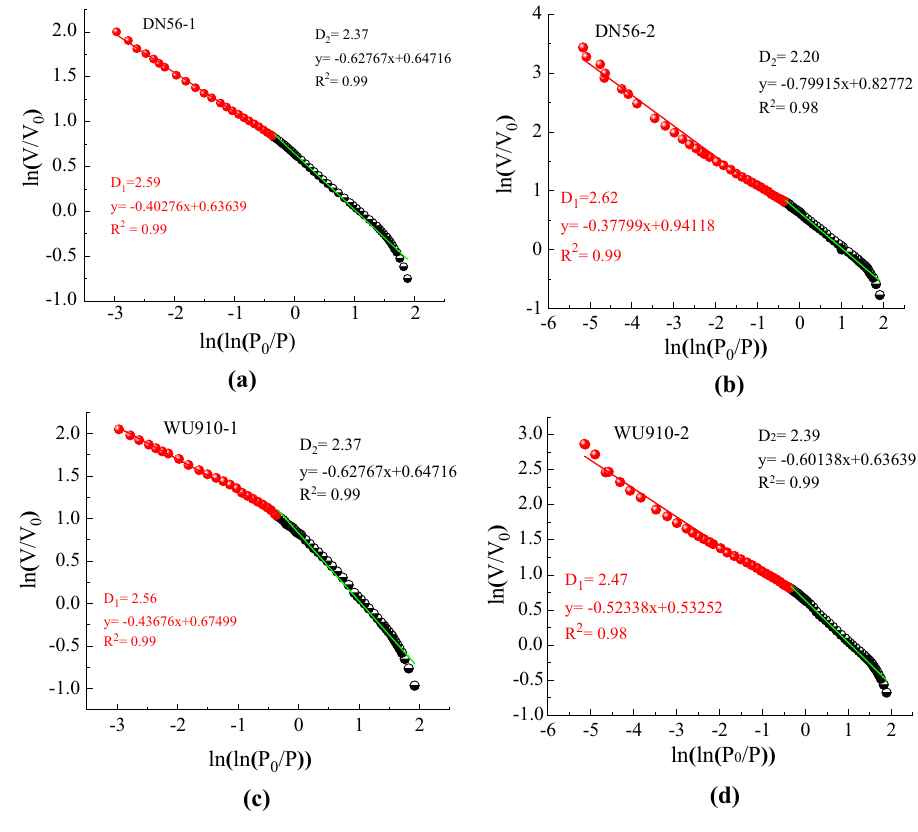
Fig. 7 Fractal characterization determined by N 2 -adsorption experiment